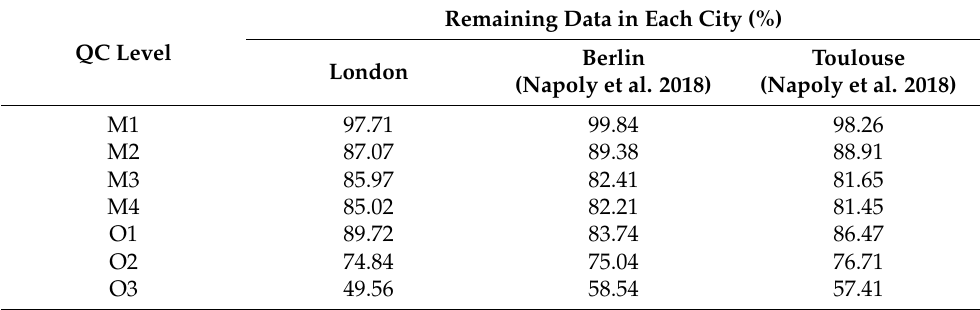
Table 3. The amount of crowdsourced temperature data remaining after each step of the quality check for London and two cities (Berlin and Toulouse) tested by Napoly et al.